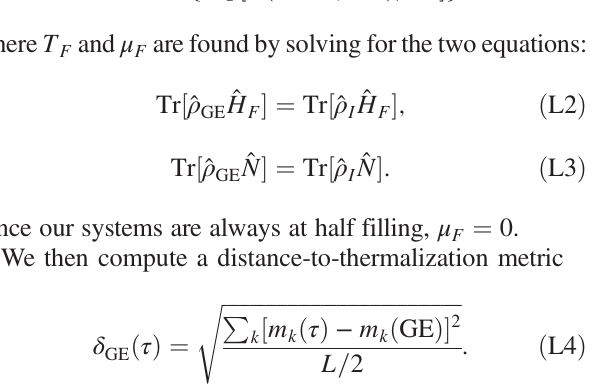
) obtained in k ˆ H (labeled F ˆ H F 0 . 2 r ¼ r